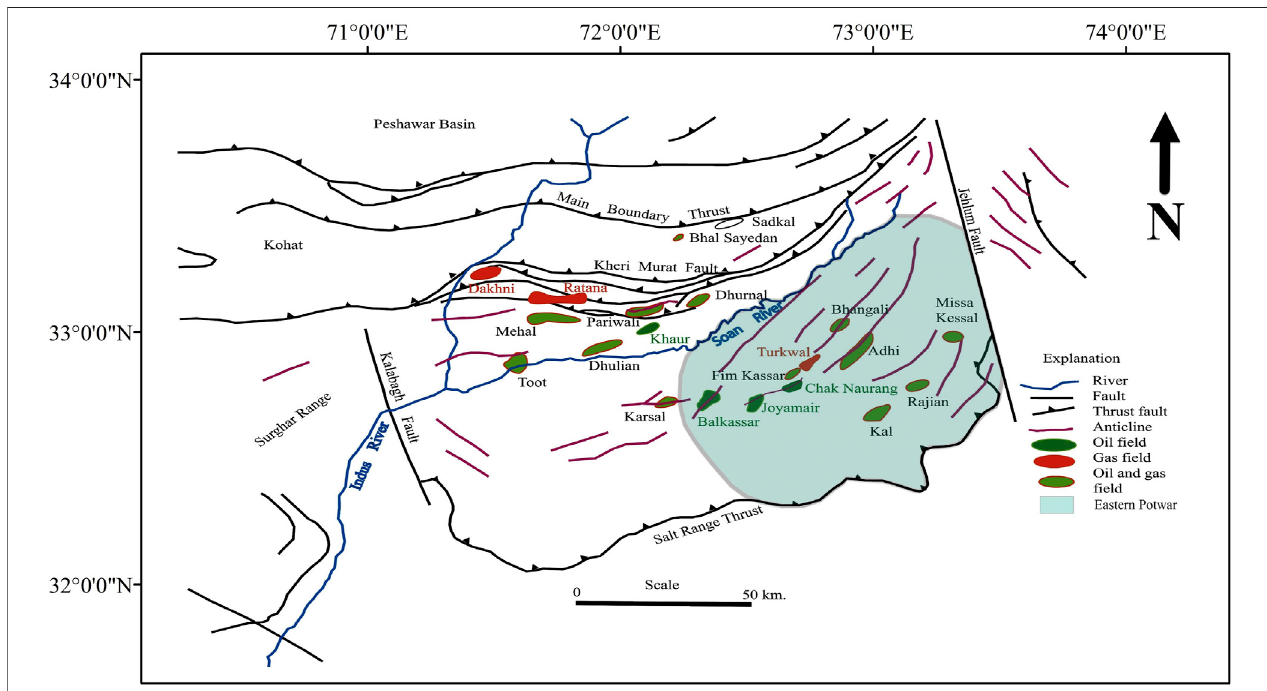
FIGURE 2 | Generalized structural map of Potwar and Kohat basins with major oil and gas fi elds. Study area (eastern Potwar) is highlighted by light blue polygon coveringthe fi eldsusedforinvestigationofporepressurepredictions.MajorfaultsarerunninginNE – SWdirectioninthesehydrocarbonproducing fi elds(Wandrey etal.,